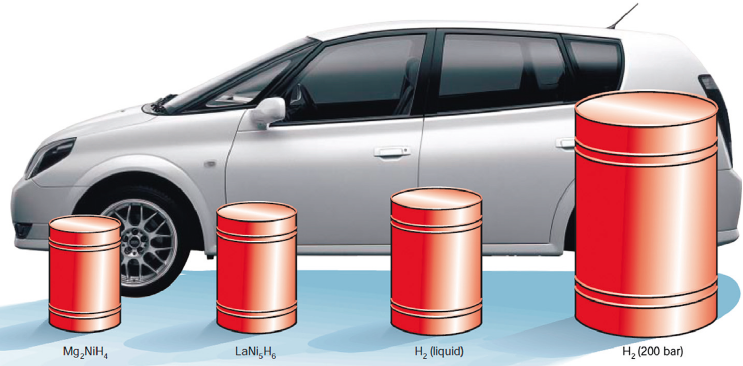
Figure 15: Schematic representation of the volumetric scale of storage space required for 4 kg of hydrogen with different modes of storage [259, 268]. Car image is a courtesy of Toyota press information, 33rd Tokyo Motor